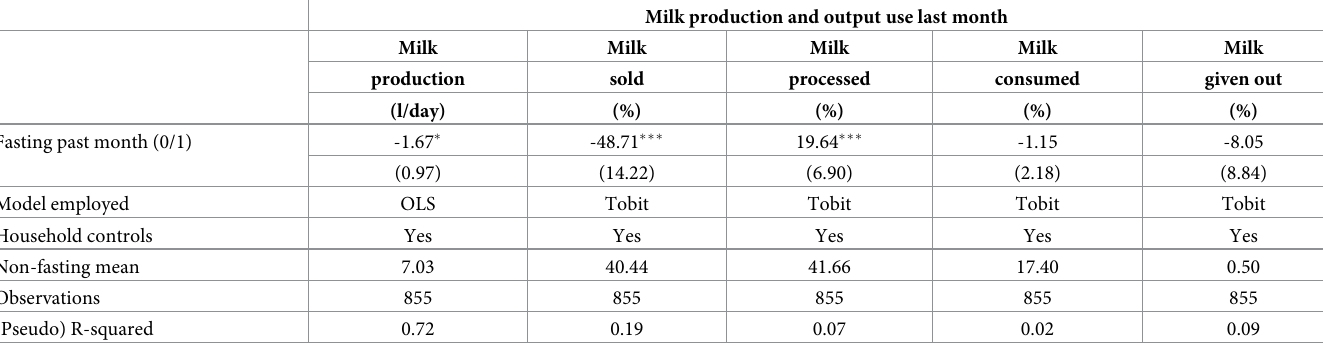
Table 7. Effect of the presence of a long fasting season in the last month on milk production and output use one month prior to the interview.